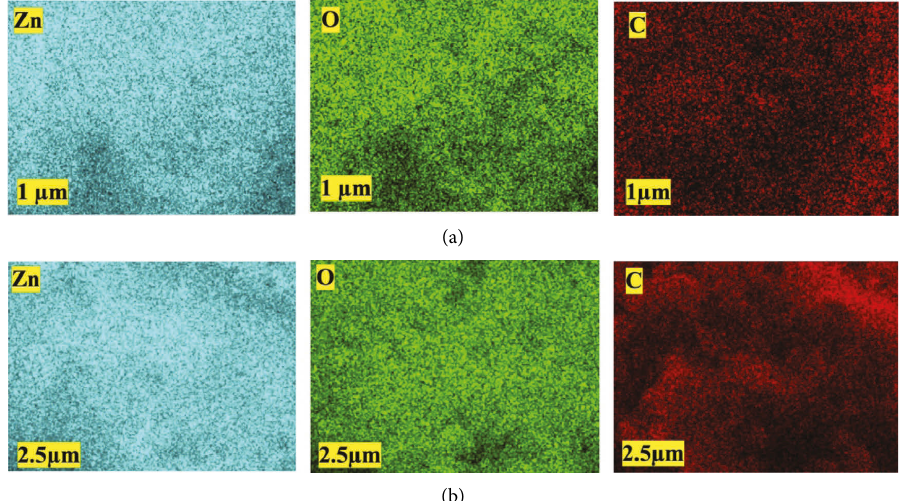
Figure 3: Elemental mappings of the homogeneous dispersion of zinc (Zn), oxygen (O), and carbon (C) elements in (a) zinc oxide nanoparticles (ZnONPs) and (b) plant-fabricated zinc oxide nanoparticles (PF-ZnONPs).